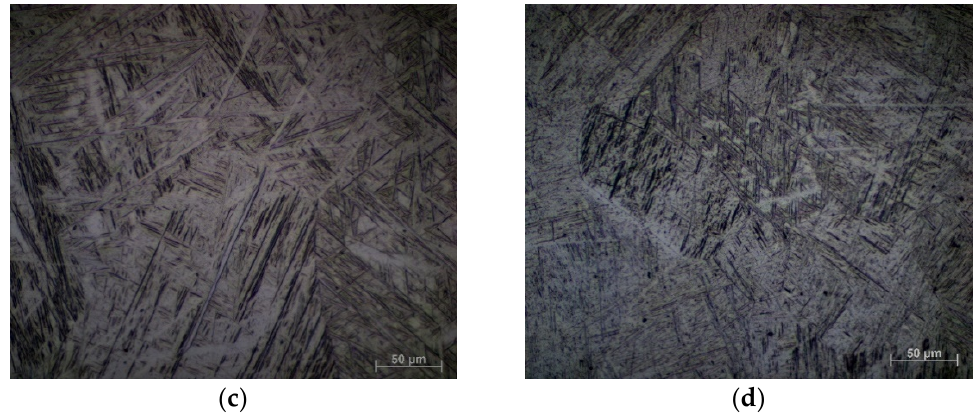
Figure 5. Laser spot welds cross-section macrographs: ( a ) SLM and ( b ) EBM. The letters refer to fusion zone (FZ), connector (C), and tube (T). The arrows indicate, approximately, the laser beam optical axis. Micrographs of FZ: ( c ) SLM and ( d ) EBM.